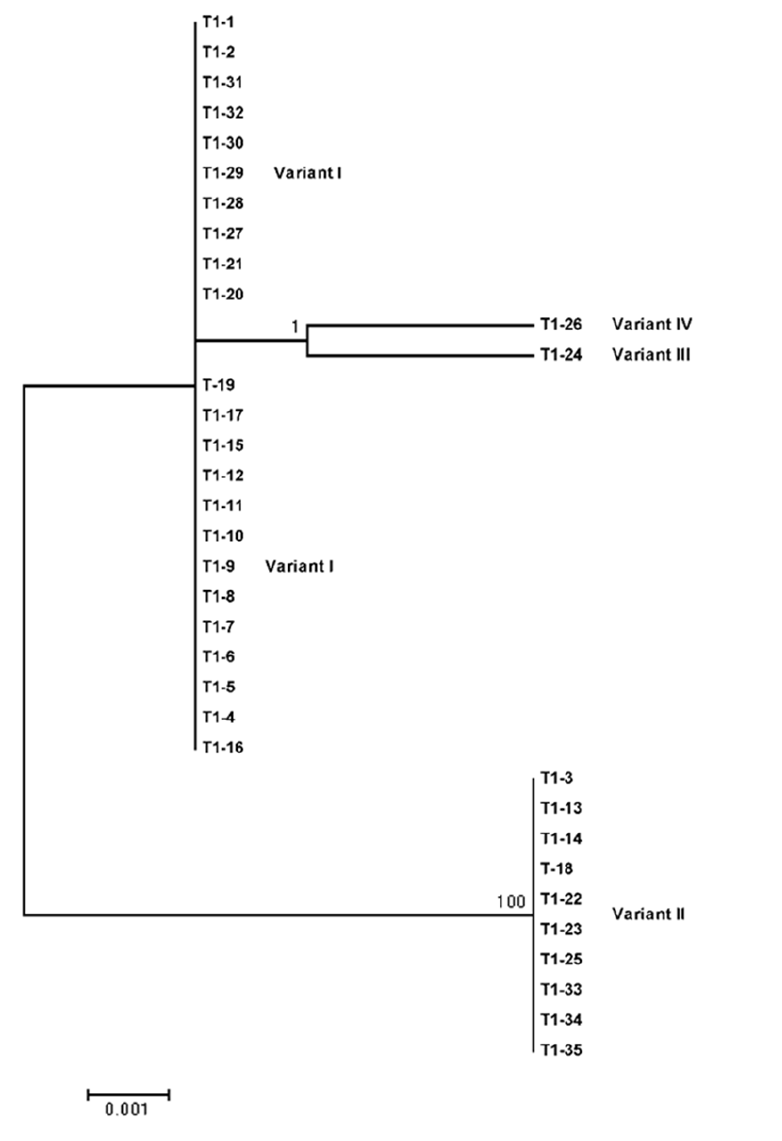
Figure 3. Phylogenetic analysis of Tomato chlorotic dwarf viroid (TCDVd) sequence variants. The evolutionary history was inferred by using the Maximum Likelihood method based on the Tamura-Nei model. The percentage of trees in which the associated taxa clustered together is shown above the branches. Initial tree(s) for the heuristic search were obtained automatically by applying Neighbor-Join and BioNJ algorithms to a matrix of pairwise distances estimated using the Maximum Composite Likelihood approach, and then selecting the topology with superior log likelihood value. The tree is drawn to scale, with branch lengths measured in the number of substitutions per site. Evolutionary analyses were conducted in